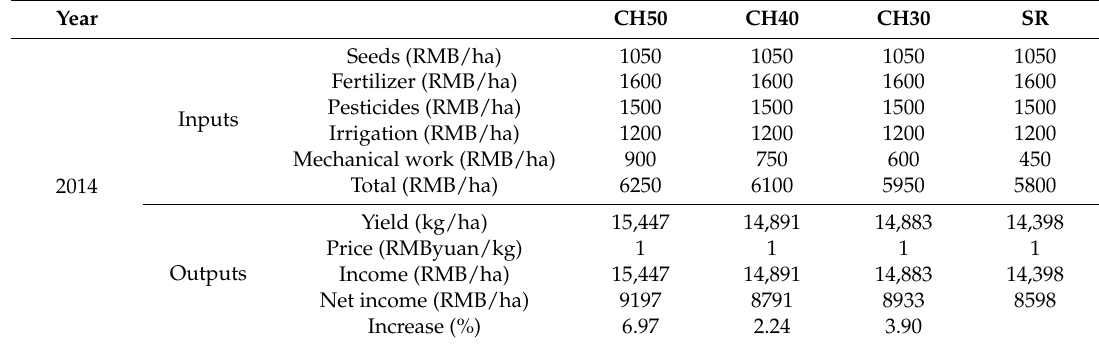
Table 9. Inputs and outputs of maize production for different treatments in the year,